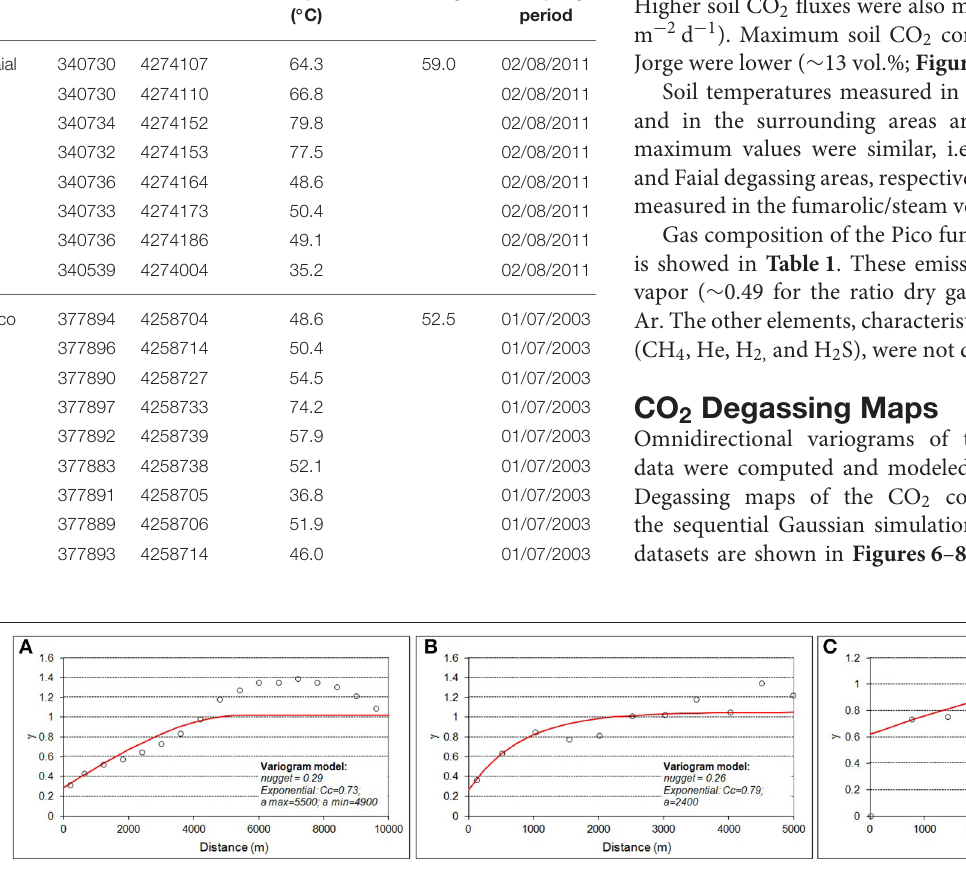
Frontiers in Earth Science |